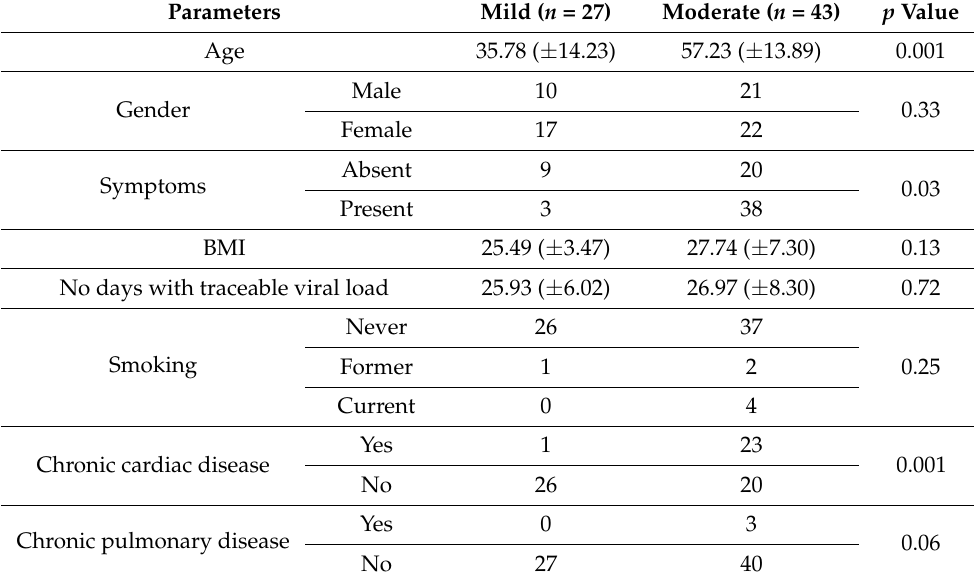
Table 1. Patients’ characteristics considering COVID-19